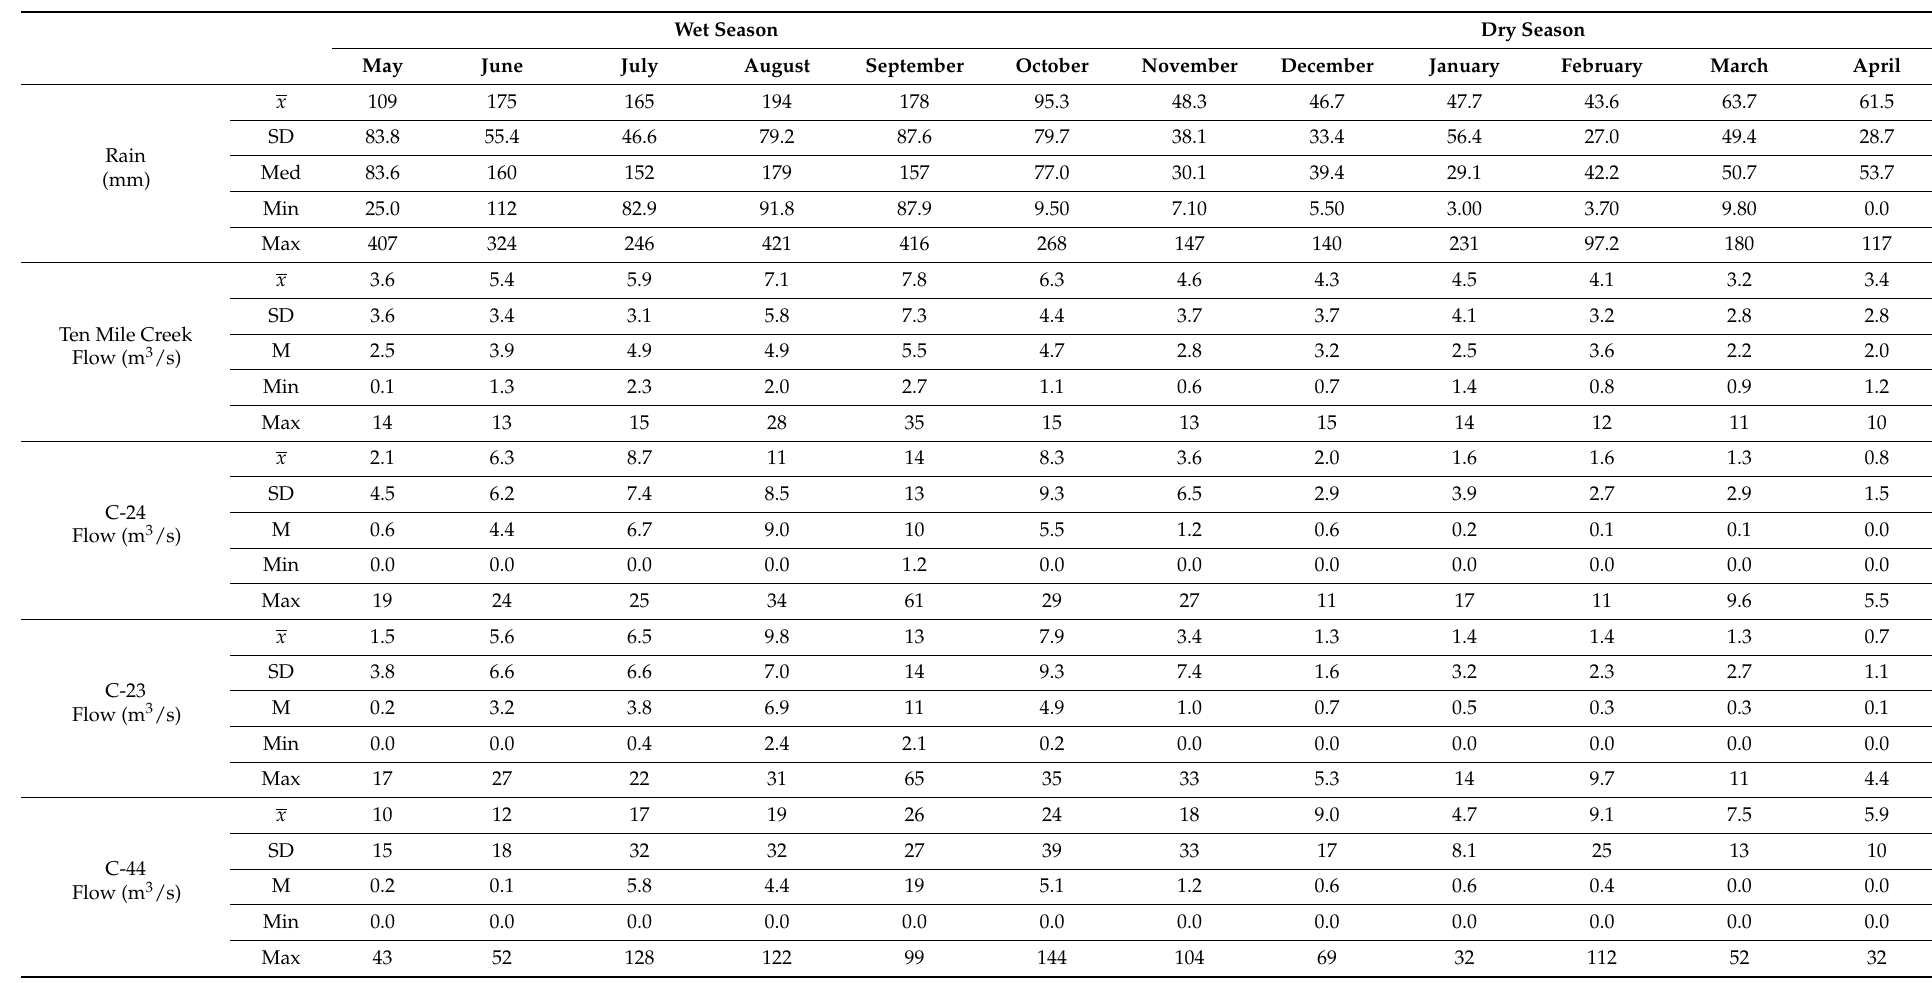
Table 3. The monthly mean ( x ) standard deviation (SD), median (Med), and minimum (Min), and maximum (Max) for rainfall and canal flow values for the period of November 1999–October 2019.